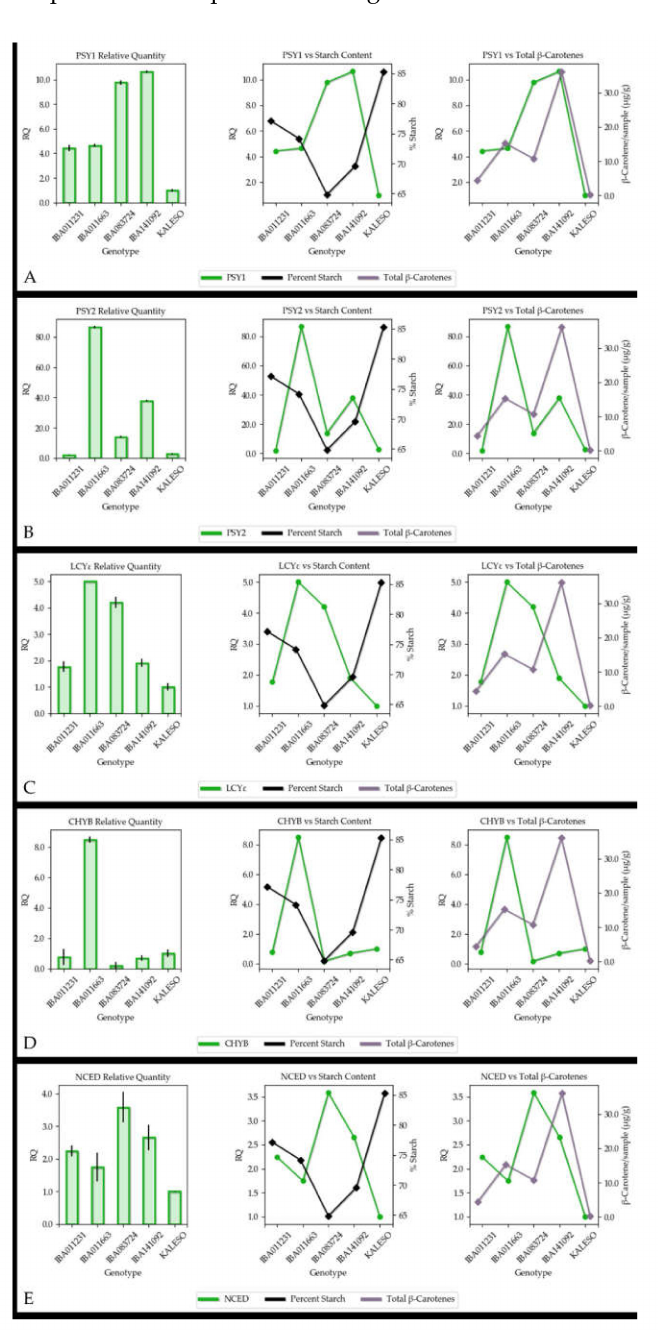
Figure 6. Relative gene expression (RQ) and comparison between selected metabolites across five cassava genotypes. ( A )–( E ) show relative expression of PSY1, PSY2, LCY ε , CHY β and NCED1 and their expression correlation with starch and total β -carotene composition across selected